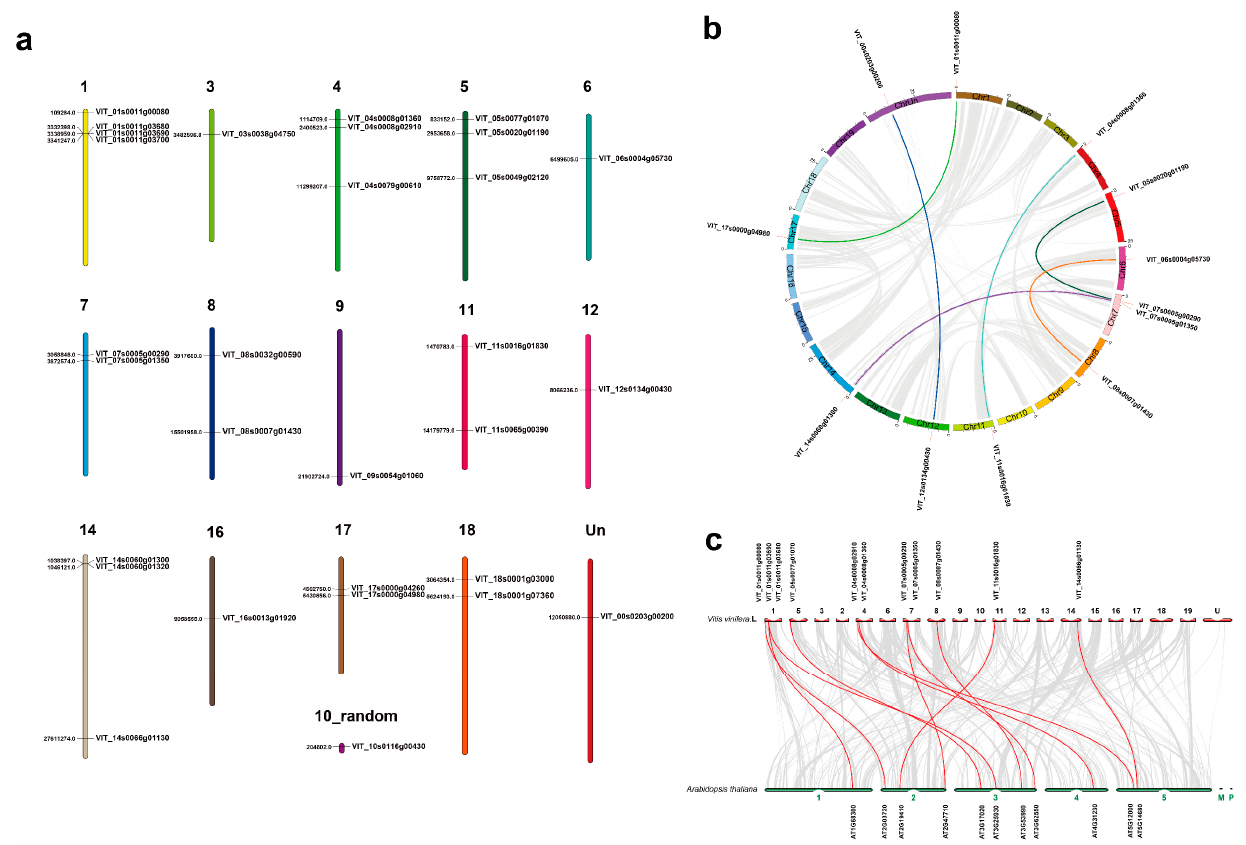
Figure 3. The chromosome distribution of VvUSP genes ( a ), collinearity analysis of VvUSPs ( b ) and collinearity analysis of VvUSPs and AtUSPs ( c ). The USP genes and USP homologs are represented in red and grey, respectively. Table 2. Calculation of Ka , Ks , and Ka/Ks and divergent time of VvUSP gene pairs. Duplicated Gene Pairs